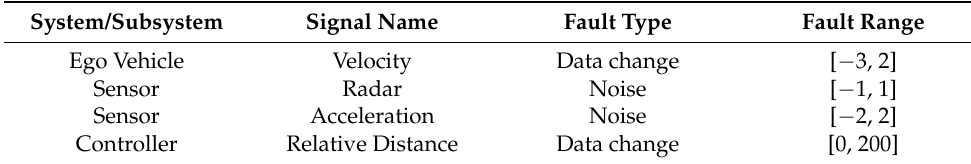
Table 2. Domain knowledge for action signal.